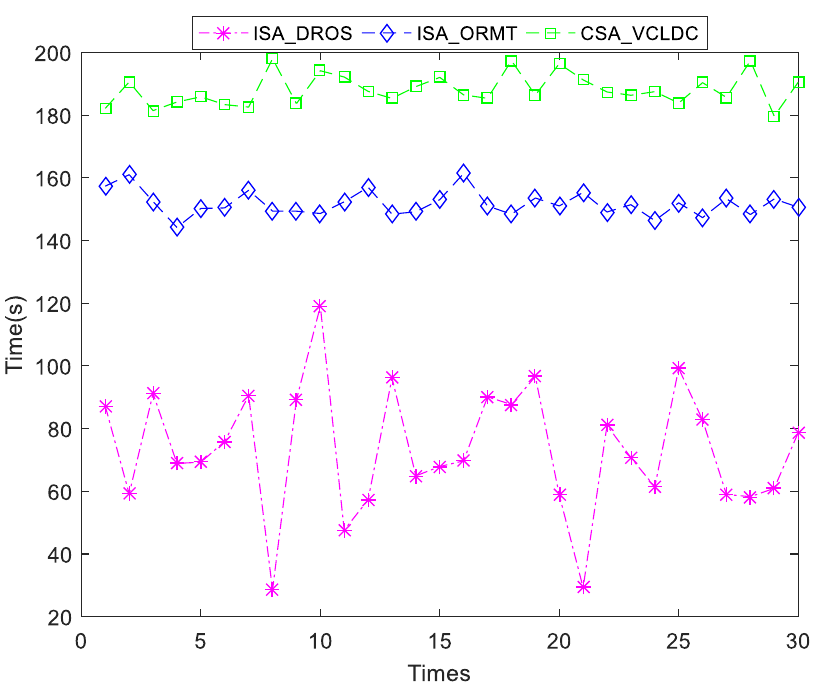
Figure 17. Solve for the average execution time of the product described in Figure 16.